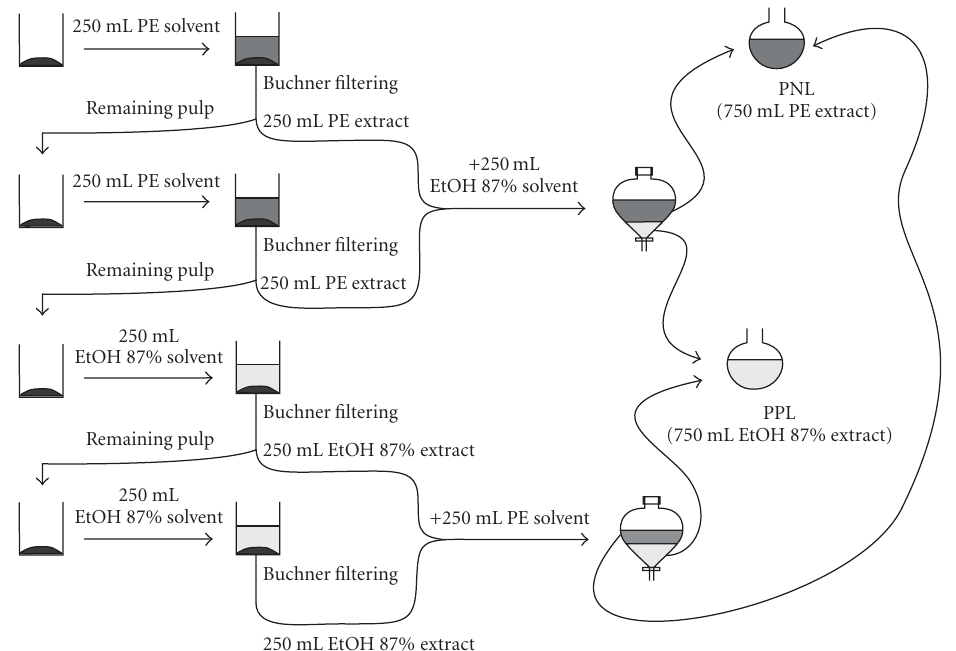
Figure 1: Schematic representation of polar lipid extraction from olive pomace, abbreviated as PPL in the text. PNL: pomace neutral